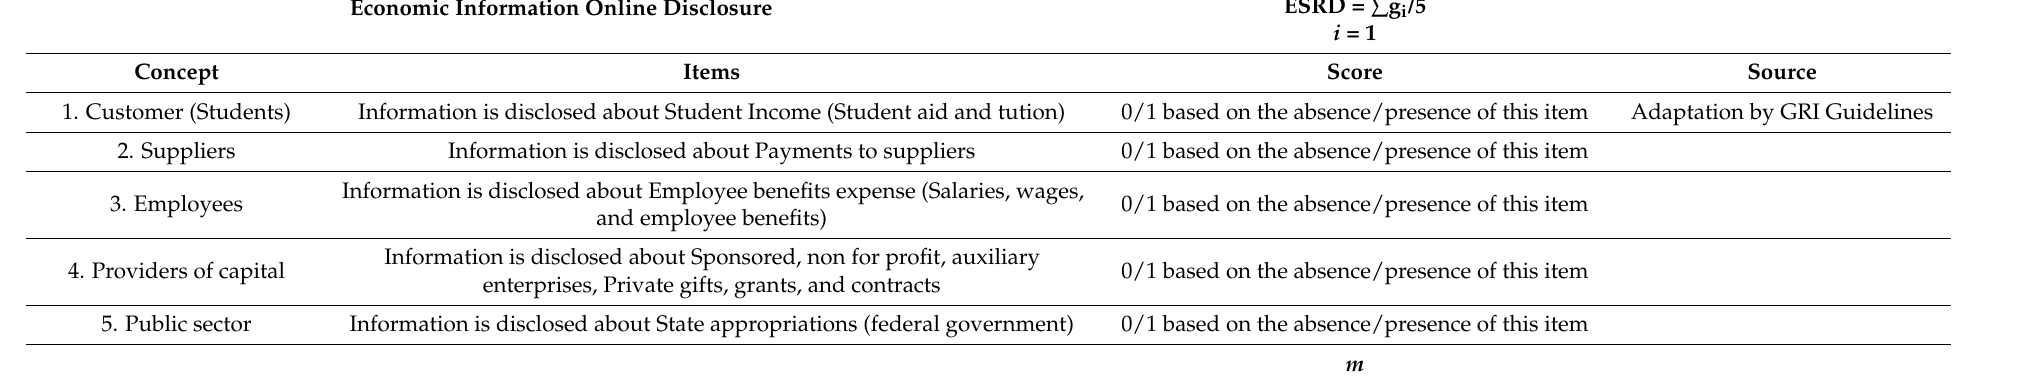
Table 3. Online disclosure of specific CSR